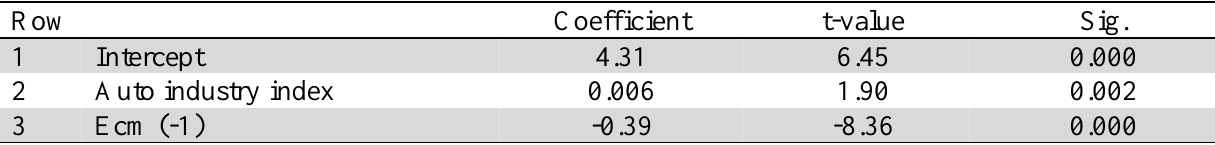
The summary of the results of ADRL Correction-Error Row